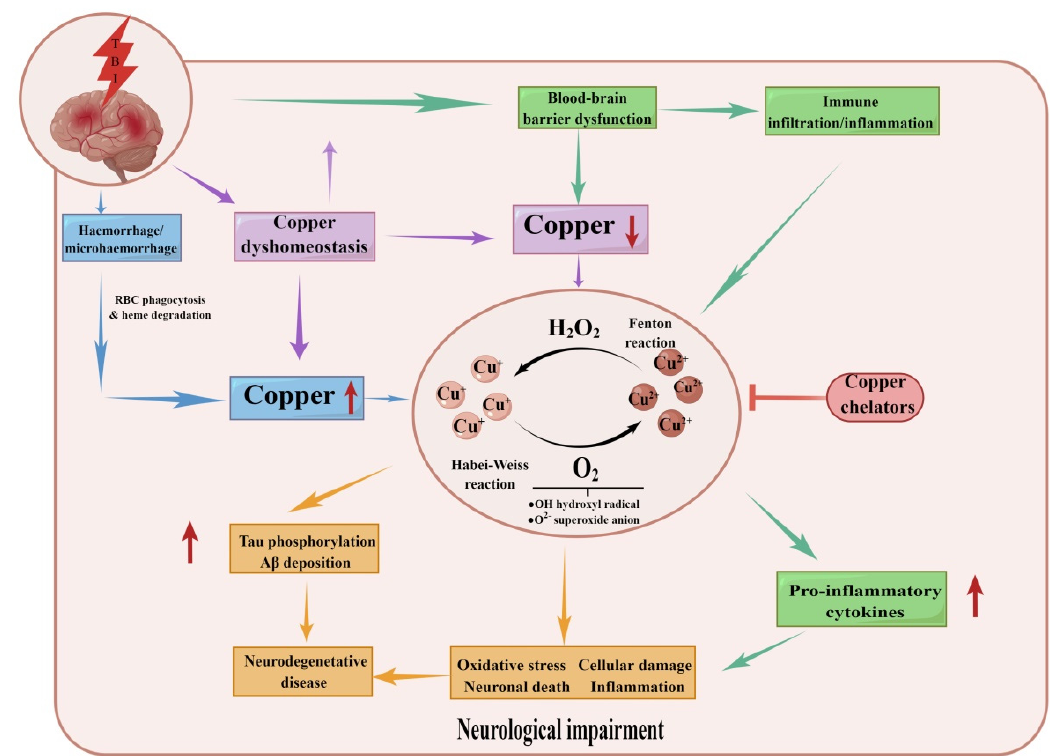
Figure 3. The outcomes of imbalanced copper balance after TBI. TBI leads to several serious conse- quences, including BBB breakdown, haemorrhage, and copper dyshomeostasis. Together this leads to a copper increase or decrease in the brain. Copper is involved in the Haber–Weiss/Fenton reaction, promoting oxidative stress, neuronal death, inflammation onset and tau phosphorylation/beta depo- sition. This leads to pathological changes in traumatic brain injury and ultimately increases the risk of neurological decline and neurodegenerative